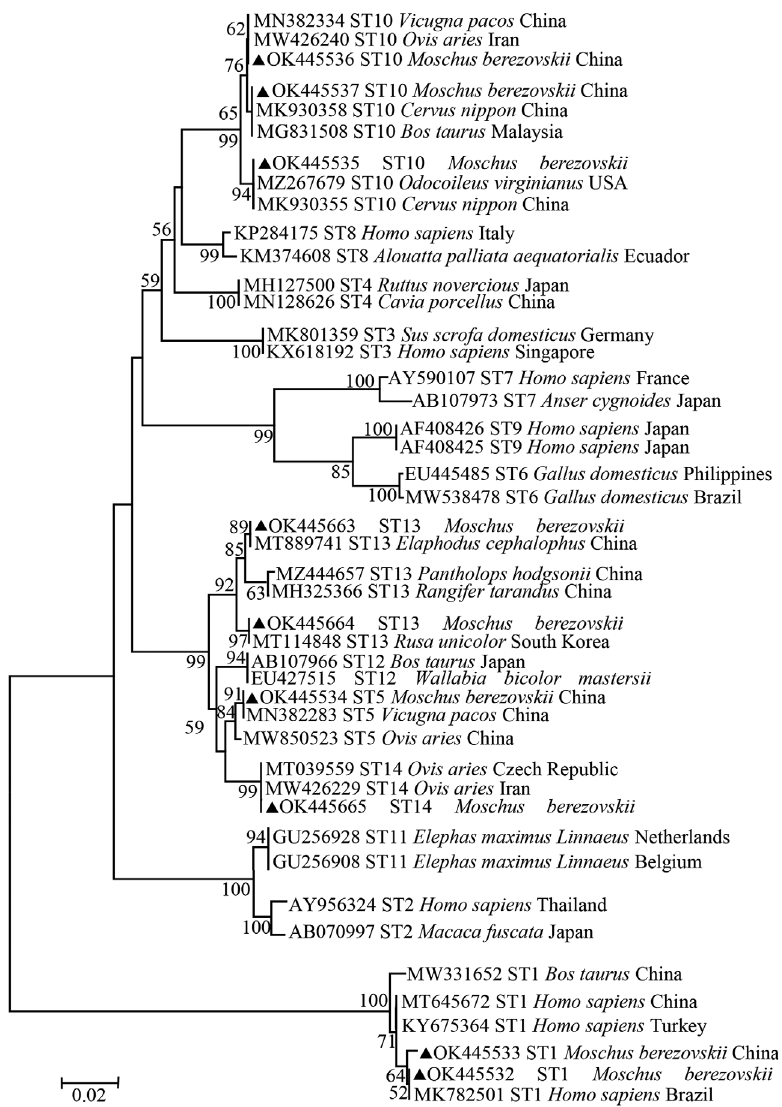
Figure 2. Partial Phylogenetic relationships among nucleotide sequences of Blastocystis sp. partial small subunit ribosomal RNA (SSU rRNA) genes. The neighbor-joining method was used to construct the trees by the Kimura-2-parameter model. The numbers on the branches are percent bootstrap support values from 1000 replicates; only values of more than 50% are shown on the tree. Each sequence is identi fi ed by its accession number, subtype, host origin, and country. Sequences marked with black triangles are representative sequences identi fi ed in this